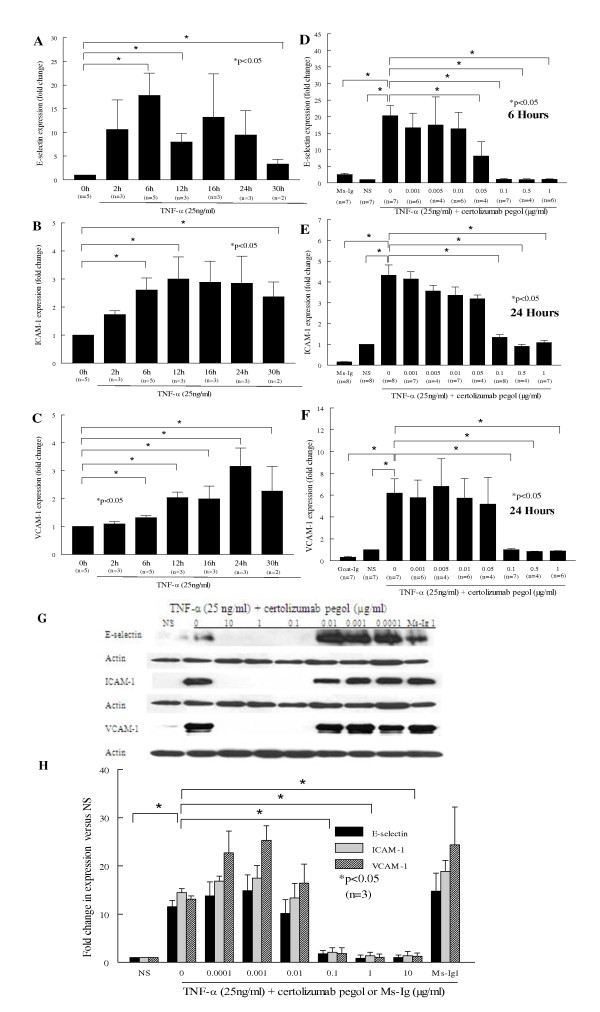
Certolizumab pegol inhibits TNFα-induced adhesion molecule expression on human dermal microvascular endothelial cells. E-selectin, intercellular adhesion molecule-1 (ICAM-1) and vascular cell adhesion molecule-1 (VCAM-1) are expressed on human dermal microvascular endothelial cells (HMVECs), inhibited by certolizumab pegol. Cell surface ELISAs were performed to determine the peak expression time of each adhesion molecule on HMVECs induced by TNFα (25 ng/ml). (A) E-selectin, (B) ICAM-1, and (C) VCAM-1 expression is significantly greater on TNFα-stimulated HMVECs compared with the nonstimulated (NS) group. HMVEC expression of E-selectin peaks at 6 hours, while ICAM-1 and VCAM-1 peak at 24 hours (*P < 0.05). Peak expression time points for each adhesion molecule were then used to examine whether certolizumab pegol can inhibit TNFα adhesion molecule induction on HMVECs. (D) E-selectin, (E) ICAM-1, and (F) VCAM-1 expression on HMVECs was stimulated with TNFα (25 ng/ml) in the presence or absence of different concentrations of certolizumab pegol (0.0001 to 10 μg/ml) or mouse-IgG (Ms-Ig) control for 6 hours for E-selectin and for 24 hours for ICAM-1 and VCAM-1 expression, when ECs protein lysates were collected. (G), (H) Western blot results indicate that E-selectin, ICAM-1 and VCAM-1 expression are entirely blocked by higher concentrations of certolizumab pegol (0.1 to 10 μg/ml). Blots are representative of three samples. The results are shown as the fold change of treatment samples to the NS group ± standard error of the mean. n, number of experiments.